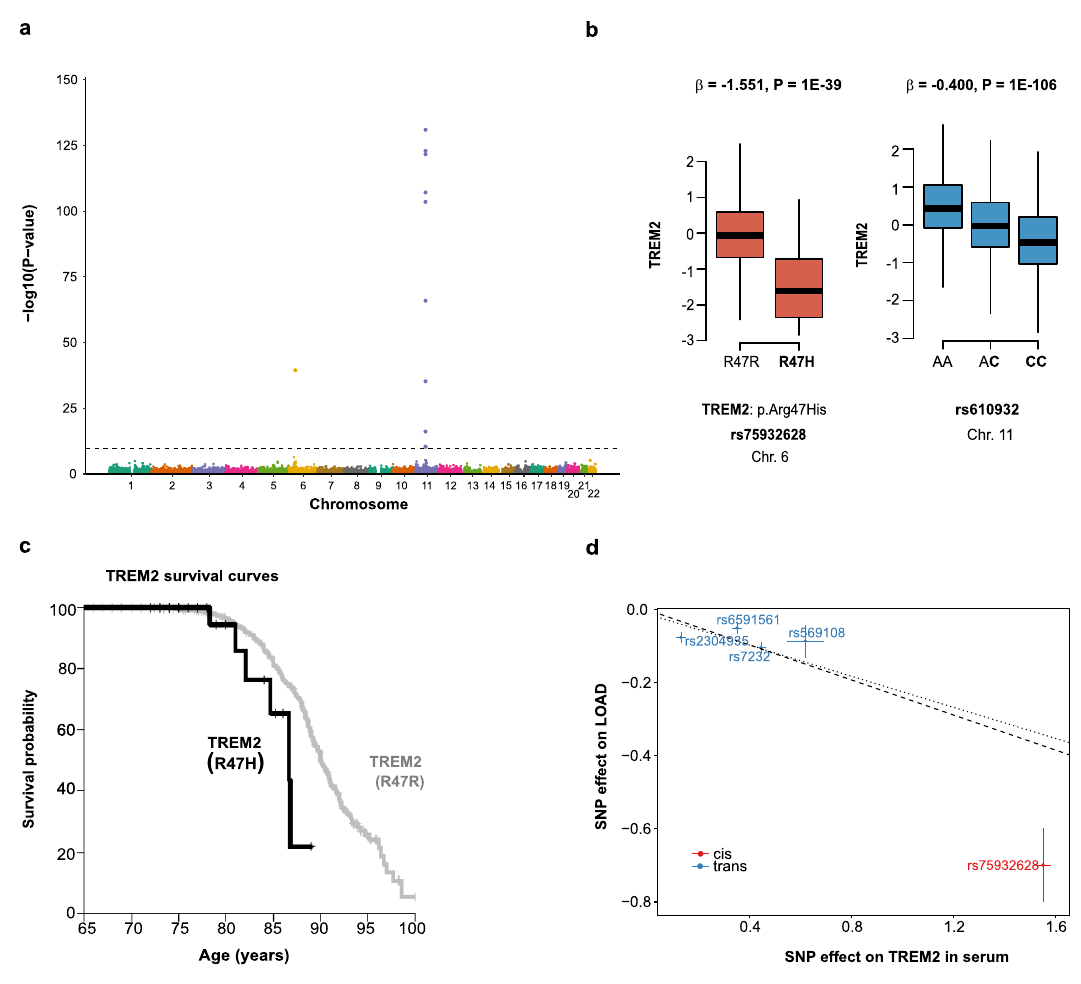
Fig. 4 Effects of distinct risk loci for LOAD converge on the protein TREM2. a The Manhattan plot highlights variants at two distinct chromosomes associated with serum TREM2 levels. Study-wide signi fi cant associations (linear regressions) at P < 1.92 × 10 − 10 (two-sided) are indicated by the horizontal line. The y -axis shows the − (log 10 ) of the P -values for the association of each genetic variant on the exome array present along the x -axis. Variants at both chromosomes 6 and 11 associated with TREM2 have been independently linked to risk of LOAD including the rs75932628 (NP_061838.1: p.R47H) in TREM2 at chromosome 6 and the variant rs610932 at chromosome 11. b The boxplot to the left shows that carriers with the p.R47H mutation, which is linked to LOAD, are associated with low TREM2 levels. The boxplot on the right shows the trans effect of the well-established GWAS risk variant rs610932 for LOAD on TREM2 serum levels, where the LOAD risk allele C (highlighted in bold) is associated with lower levels of TREM2. The x -axis of each box plot shows the genotypes for the corresponding protein-associated SNP, while the y -axis denotes the Box – Cox transformed, age, and sex-adjusted serum protein levels. Box plots indicate median (middle line), 25th, 75th percentile (box), and 5th and 95th percentile (whiskers). The P -values (two-sided) shown at the top of each plot come from linear regression analysis. c TREM2p.R47H carriers demonstrated lower survival probability post-incident LOAD compared to TREM2p.R47R carriers ( P = 0.04, two-sided). The vertical ticks correspond to individuals lost to follow-up. d Scatterplot for the TREM2 protein supported as having a causal effect on LOAD in a two-sample MR analysis. The fi gure demonstrates the estimated effects of the respective cis - and trans -acting genetic instruments on the serum TREM2 levels in AGES-RS ( x -axis) and risk of LOAD through a GWAS by Kunkle et al. 32 ( y -axis), using 21,982 LOAD cases and 41,944 controls. Each data point displays the estimated effect as beta coef fi cient = log(odds ratio), along with 95% con fi dence intervals for the SNP effect on disease (vertical lines) or SNP effect on the protein (horizontal lines). The broken line indicates the inverse variance weighted causal estimate ( β = − 0.240, SE = 0.059, P = 5.3 × 10 − 5 , two-sided), while the dotted line shows the MR-Egger regression (see Supplementary Data 5 for more